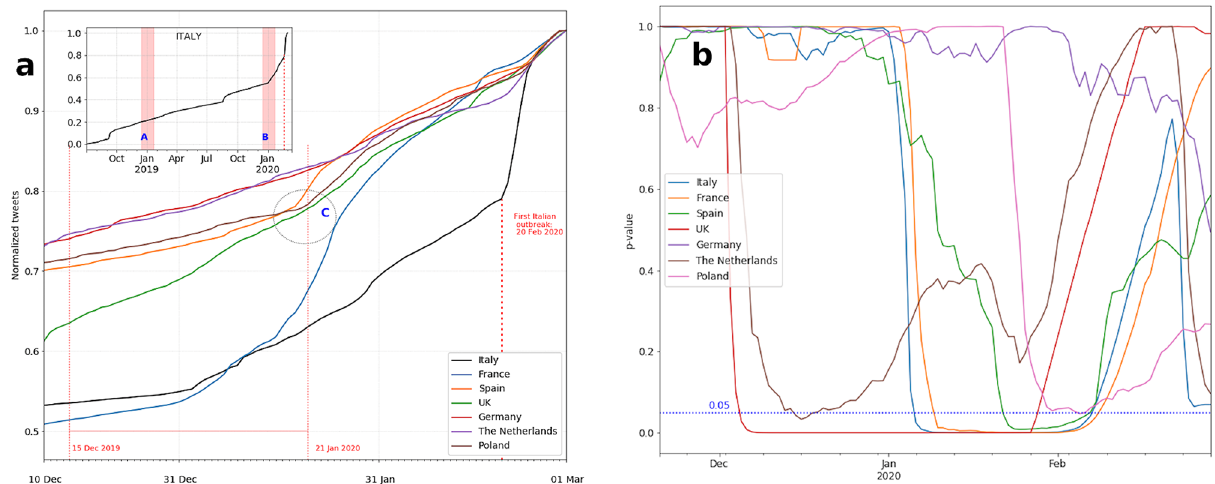
Figure 1. Anomalous evolution of pneumonia-related tweets posted across Europe since December 2019. ( a ) Cumulative rescaled number of tweets citing pneumonia from 10 December 2019 to 1 March 2020. Inset plot shows the evolution of such tweets posted in Italy from 1 July 2019 to 1 March 2020, and highlights the two winter seasons (shaded bars) used to uncover anomalous spikes of pneumonia-related tweets. ( b ) Two- sample Kolmogorov–Smirnov test of the difference between cumulative distributions of number of tweets citing pneumonia and posted in the two corresponding winter seasonal periods (2018–2019 and 2019–2020) for each of the 7 European countries. The graph reports the average p values over moving window widths w ϵ [50, 70] computed with daily